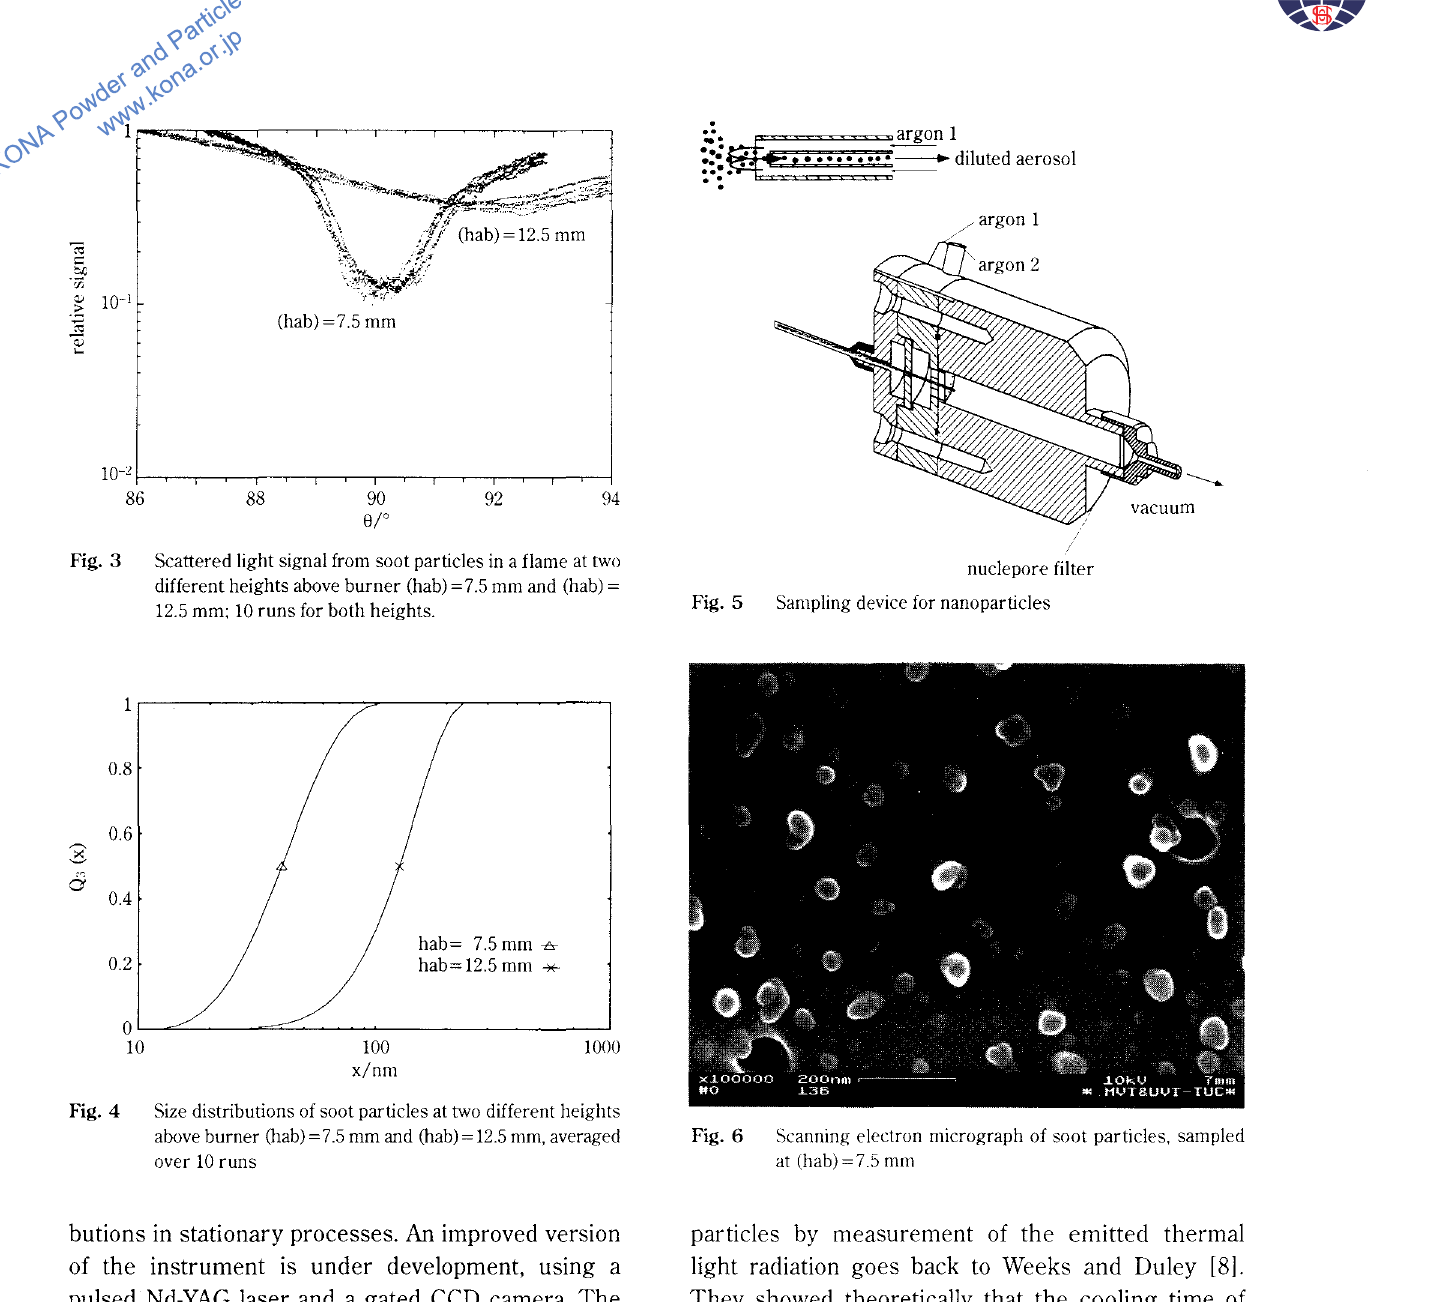
Fig. 4 Size distributions of soot particles at two different heights above burner (hab)=7.5 mm and (hab)=12.5 mm, averaged over 10 runs